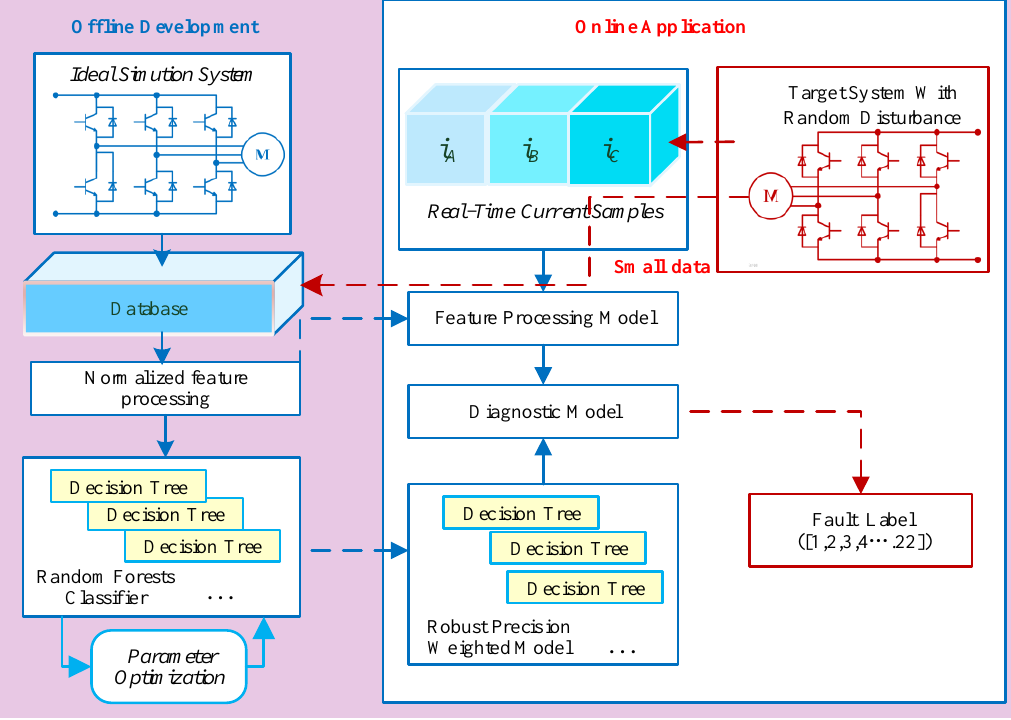
Figure 2. Framework of fault diagnosis